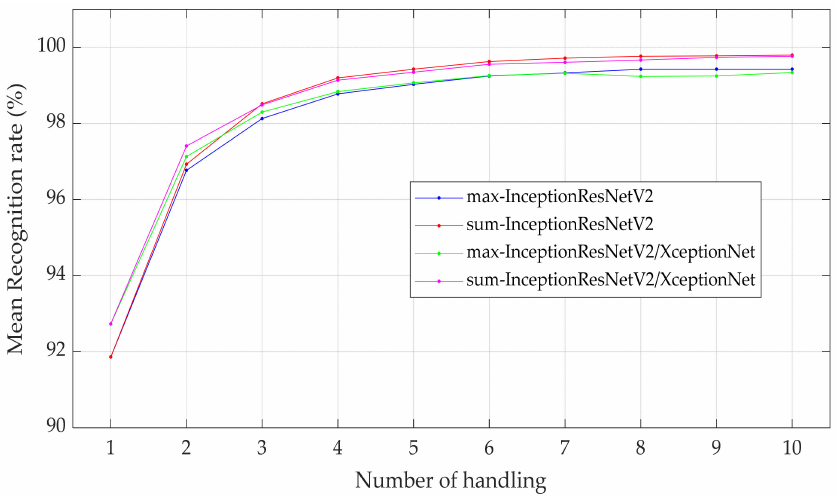
Figure 26. The recognition rate for multiple handling using a maximum probability method and summation of probability method.